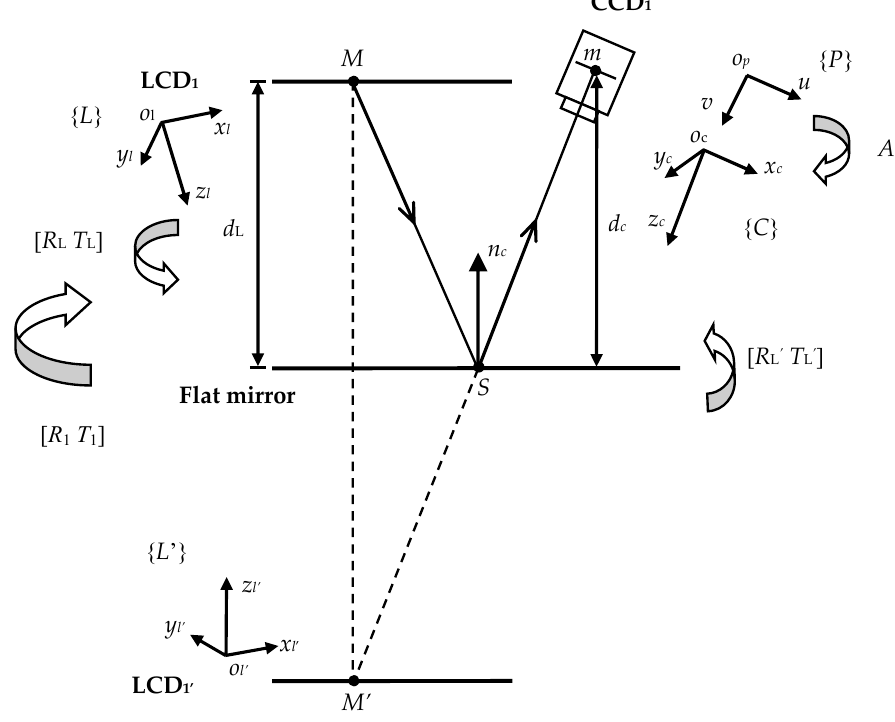
Figure 4. System calibration diagram.